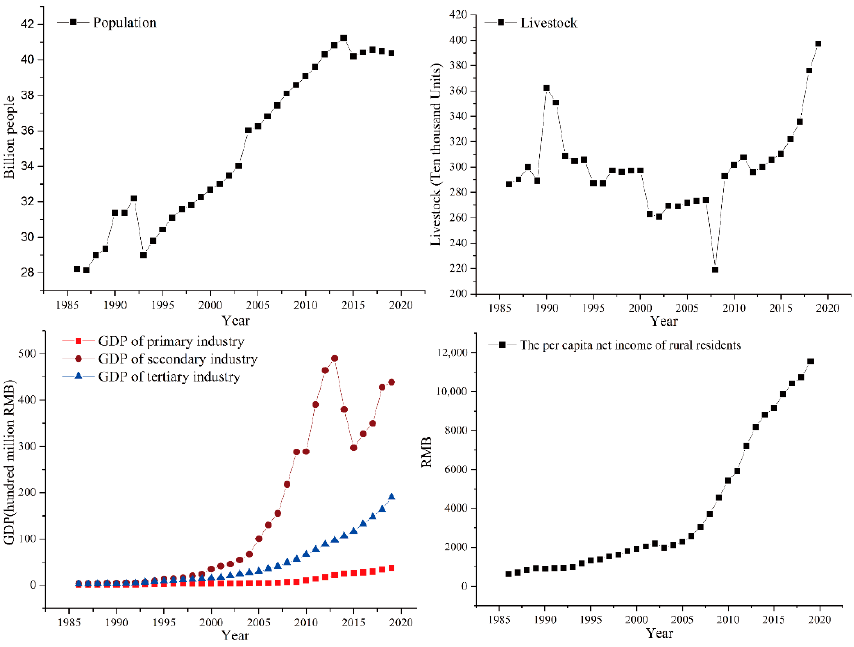
Figure 12. Socio-economic background of Qaidam Basin from 1986 to 2019.